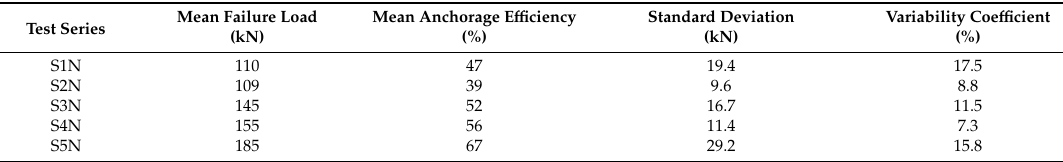
Table 9. Summary of the test results in the subsequent test series.